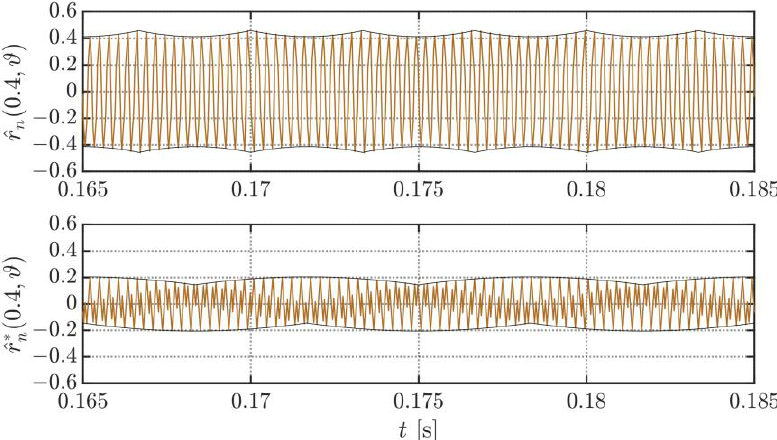
Figure 10. Normalized neutral current ripple for single ( top ) and three interleaved ( bottom , “*”) carriers with corresponding theoretical envelopes (black lines) in case of balanced modulation m = 0.4 at a switching frequency of 3.6 kHz.